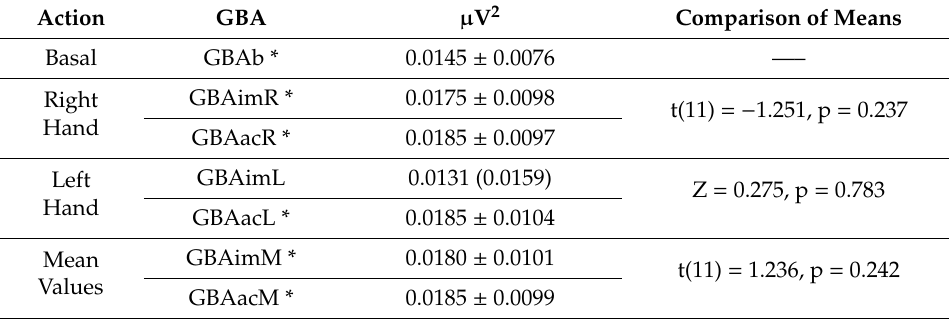
Table 2. Analysis of the GBA data obtained.